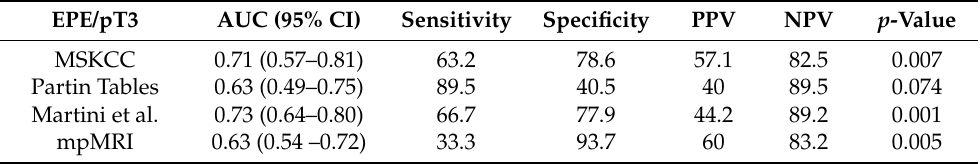
Table 4. Assessment of sensitivity, specificity, PPV, NPV, and AUC of the models in terms of